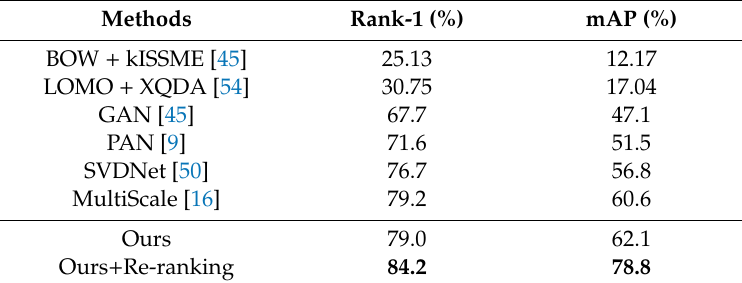
Table 6. Single query comparisons on the DukeMTMC-reID dataset.